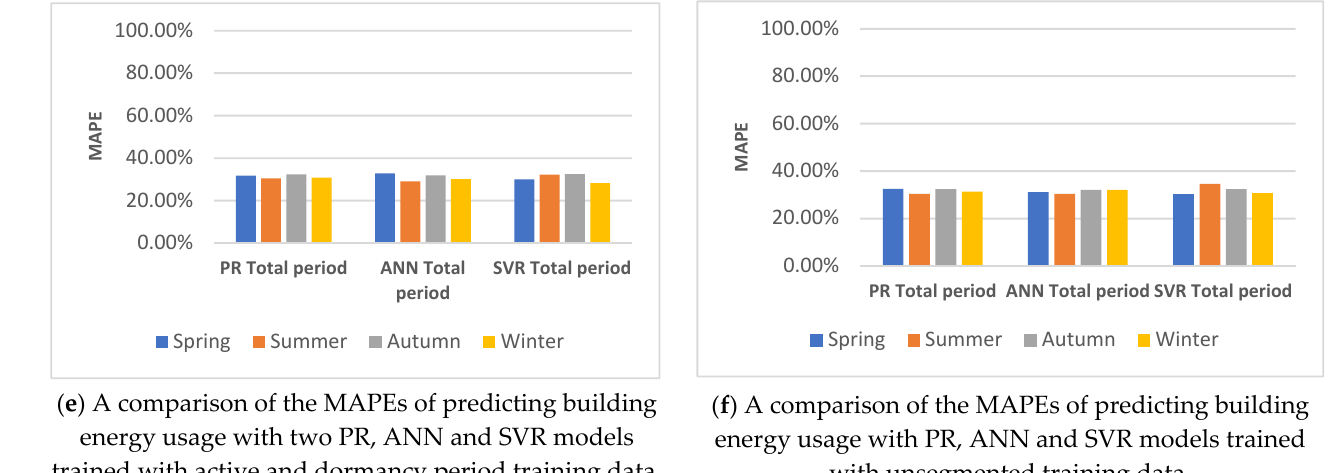
( d ) A comparison of the MAPEs of predicting building active period energy usage with PR, ANN and SVR models trained with unsegmented training data.